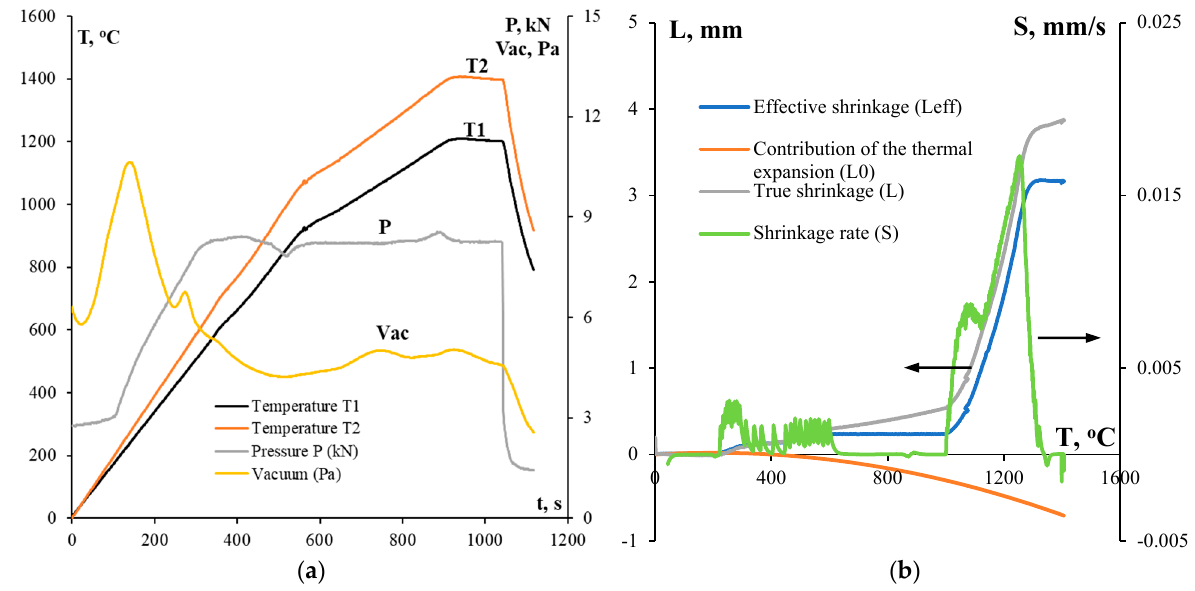
Figure 1. SPS diagrams for YPO 4 :Gd ceramics: ( a ) dependences of temperature (T), applied pressure (P), and vacuum pressure (Vac) on the time of the SPS process; ( b ) dependence of the shrinkage on the heating temperature.